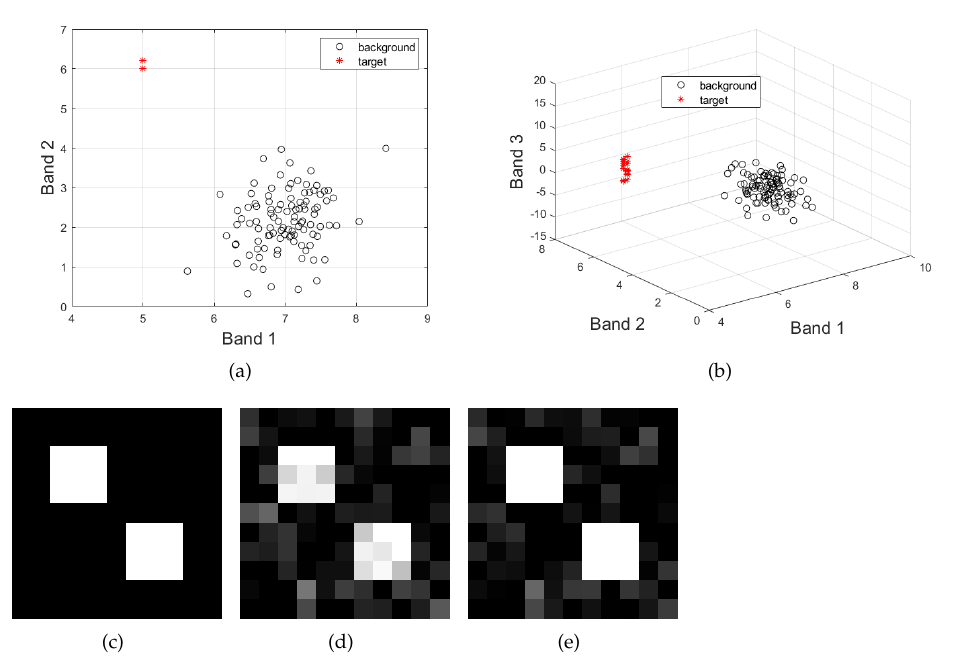
Figure 1. Results of the simulation data with 3 bands. ( a ): the distribution of the simulation image in 2-dimensional spectral space (Band 1 and 2), where the background pixels satisfy an 2-dimensional = [ 5,6 ] T (the upper left region in normal distribution. Moreover, the target vector is set to: d t 1 1 = [ 5,6.2 ] T (the lower right region in ( c )); ( b ): the distribution of the simulation image in ( c )), d t 1 2 3-dimensional spectral space, where Band 3 is a noisy one. ( c ): the groundtruth image for the target of interest; ( d ): the CEM result using full bands ( L = 3); ( e ): the CEM result using Band 1 and 2 ( L = 2), where the first pixel of the target image at the upper left corner is selected as the representative spectrum of the